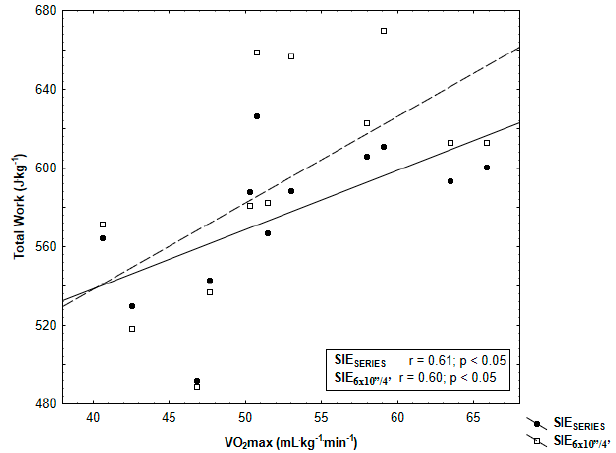
Figure 4. Pearson’s correlation of total work SIE SERIES and SIE 6 × 10” / 4’ with maximal oxygen uptake (VO 2 max) determined in incremental exercise test.